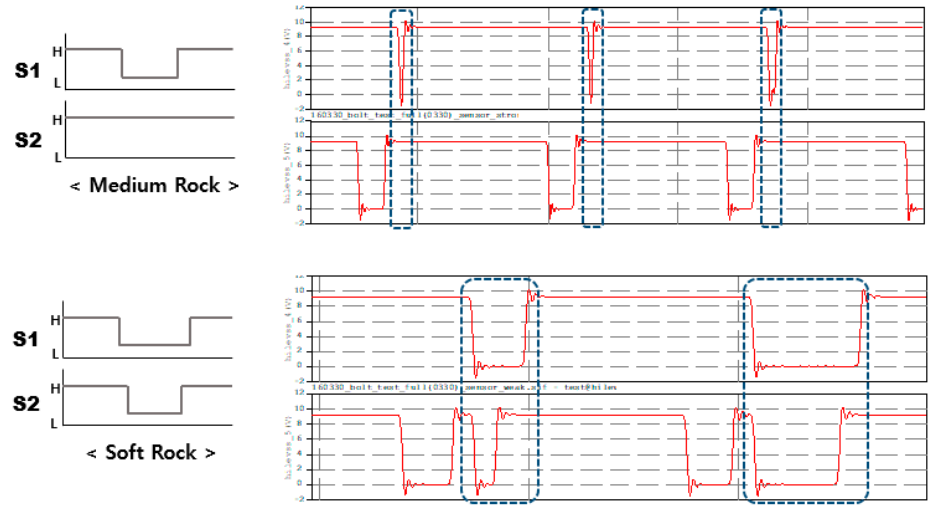
Figure 8. Proximity sensor data of each rock type.